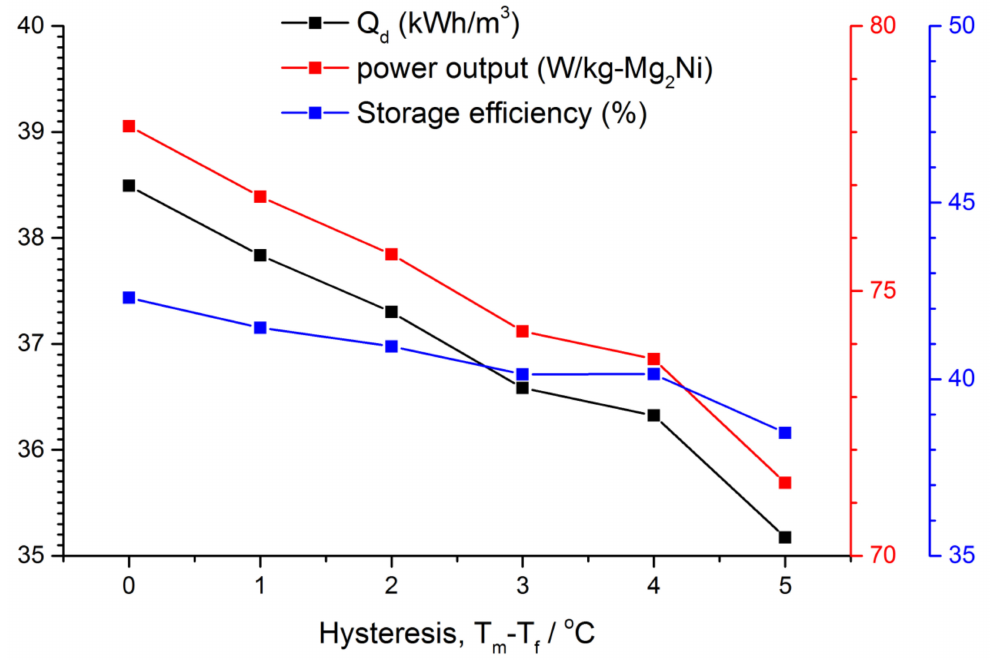
Figure 4. The e ff ect of hysteresis behavior on the heat storage